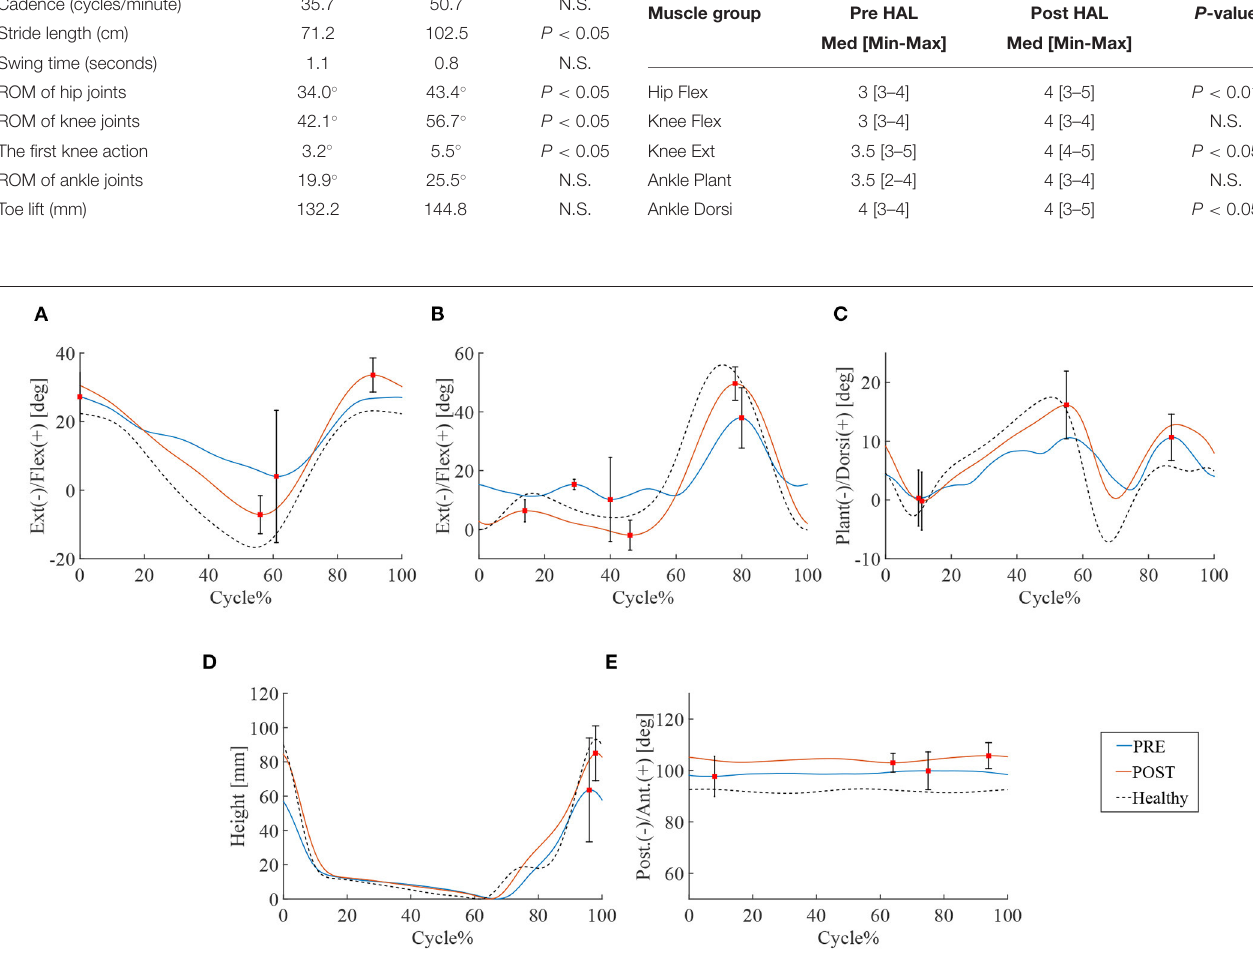
FIGURE 1 | Gait kinematics of acute group patients. Blue line is the mean of patients’ joint angle before HAL intervention, the red line is post HAL intervention, and the dotted line is gait analysis plot for healthy subjects. The percentage of walking cycle represents the normalized time. (A) Hip joint. (B) Knee joint. (C) Ankle joint. (D) Toe lift. (E)